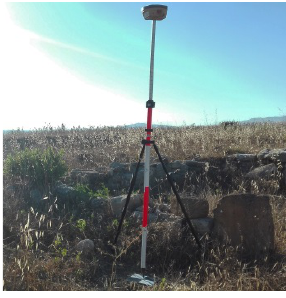
Figure 5. NRTK survey with Topcon HiperV GNSS receiver.